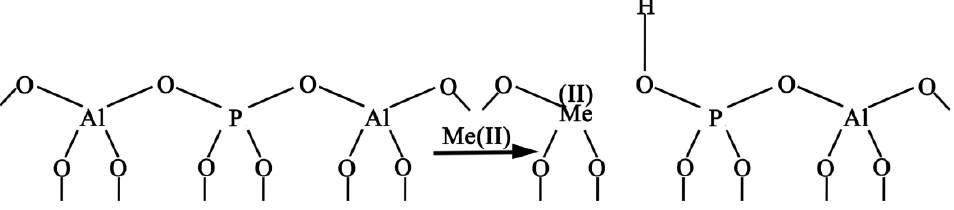
Figure 5. A model to explain the acidity generated by isomorphic substitution [30]. The Bronsted– Lewis interaction is evident.